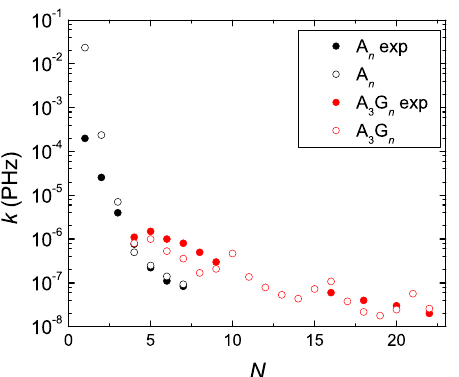
Figure 11. Comparison of experimental hole transfer rates K for A n and A 3 G n segments [96] (full circles) with our theoretical coherent pure mean transfer rates k (empty circles), as a function of the number of monomers N in the polymer. The Tight-Binding parametrization is described in the main